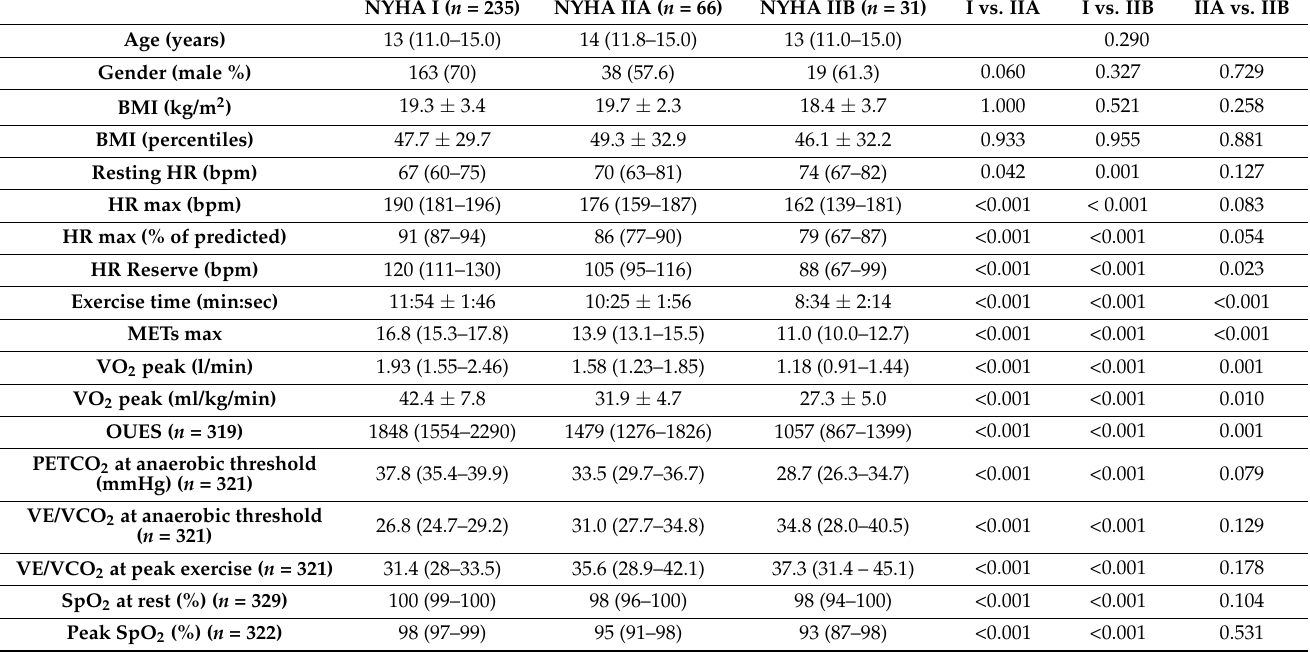
Table 1. Functional evaluation of patients with congenital heart disease in different NYHA